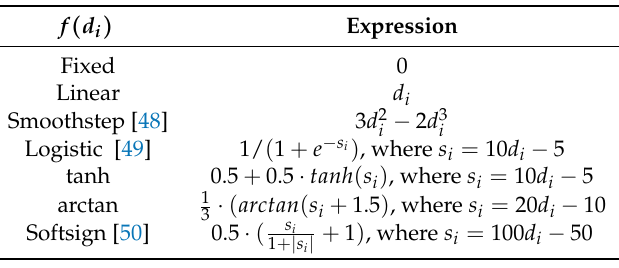
Figure 7. Pipe transparency is a function from the distance to the camera to the pipe mesh, computed at the vertices ( V i ). D Max is the maximum distance at which the transparency value ( α ) should be 0. Table 1. Different distance-based α subfunctions.